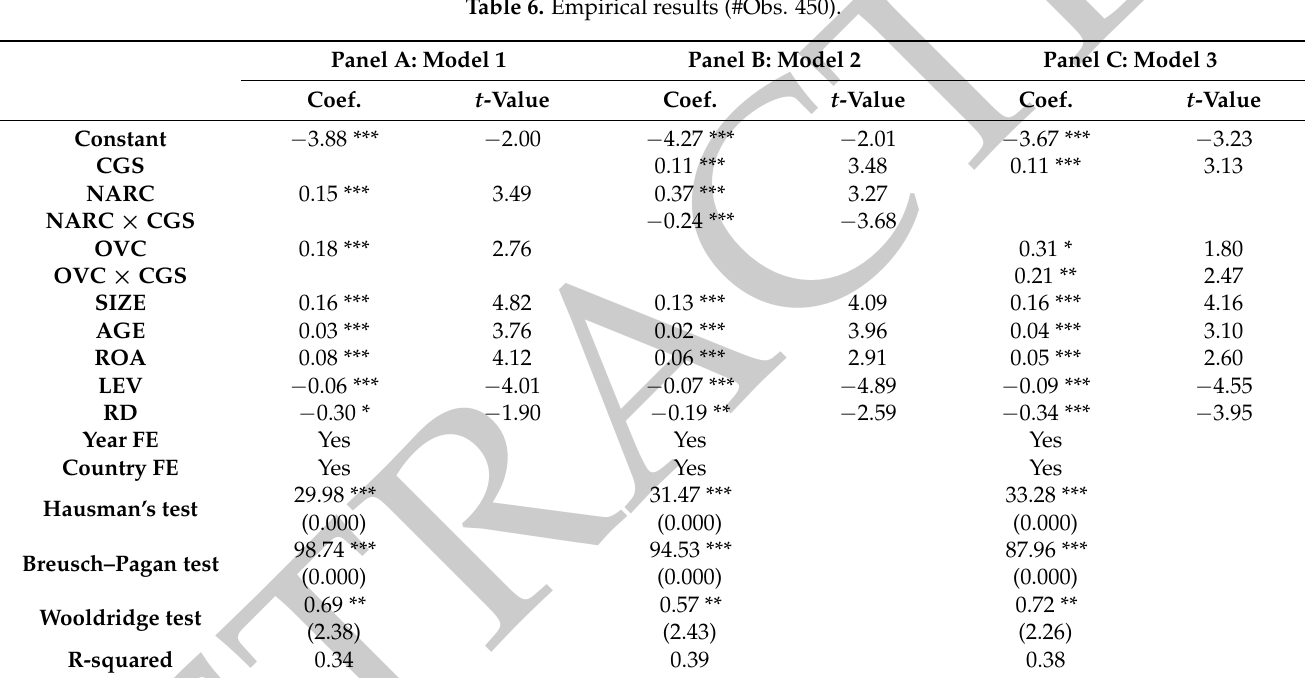
Table 6. Empirical results (#Obs.